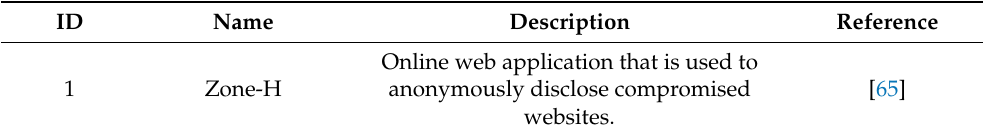
Table 14. Tools used for OSINT on security compromise